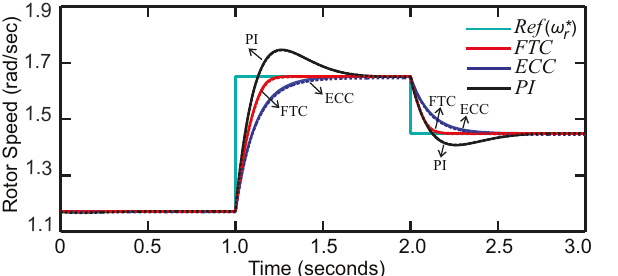
Figure 9. Comparison of the proposed FTC to the ECC and the PI controller: rotor speed reference- tracking performance.